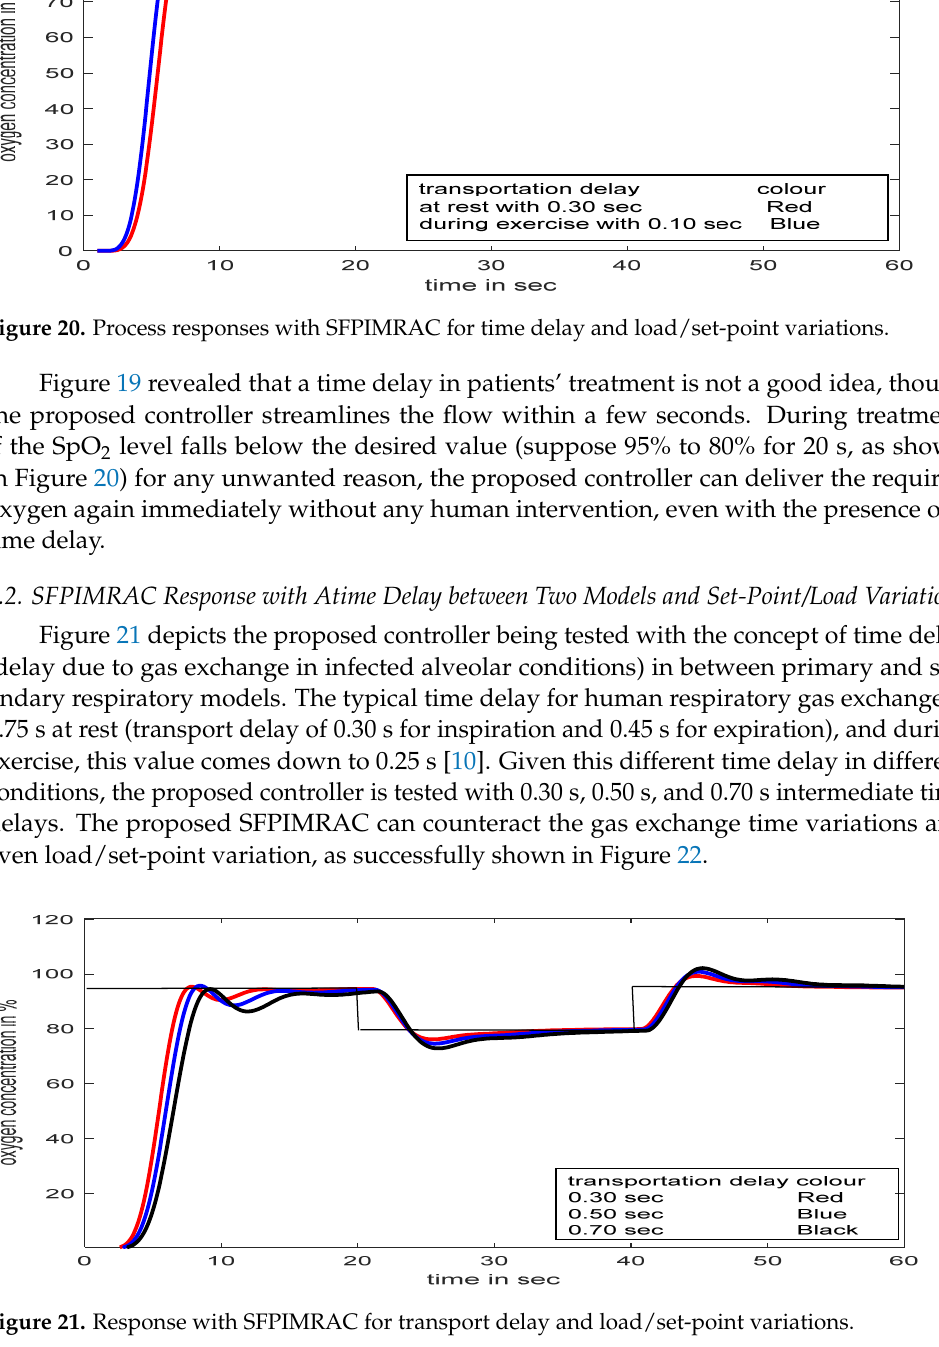
Figure 22. Simulink model of SFPIMRAC with transport delay in between respiratory model and Figure 21. Response with SFPIMRAC for transport delay and load/set ‐ point variations. Figure 21. Response with SFPIMRAC for transport delay and load/set-point gas exchange model.